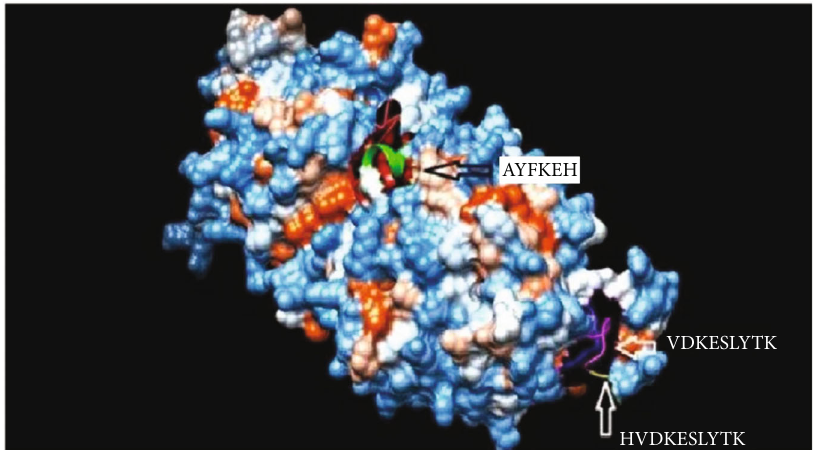
Figure 8: Structural position of the promising B-cell epitope (AYFKEH (in purple color), VDKESLYTK (in yellow color), and HVDKESLYTK (in red color)) in 3-dimensional structure of the fructose bisphosphate aldolase protein from C. glabrata using Chimera tool powered by